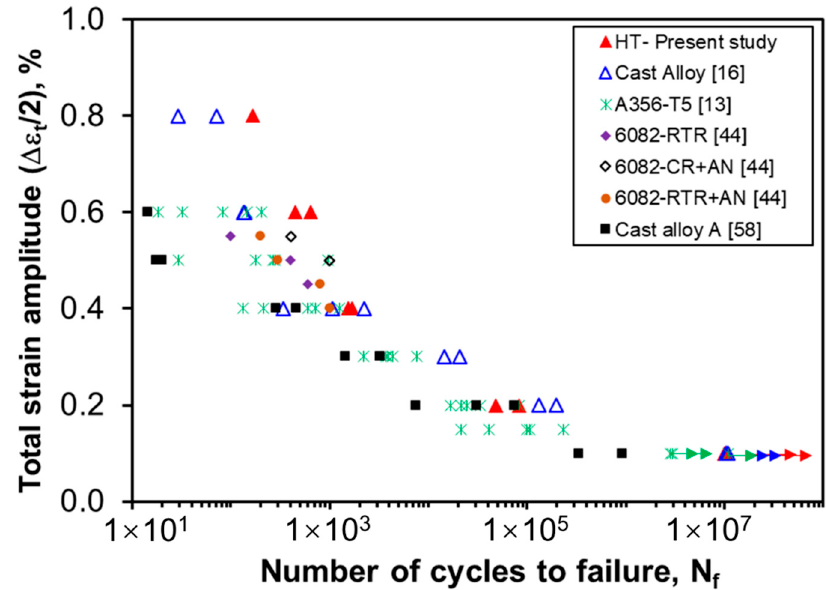
Figure 11. Fatigue life of heat-treated Al alloy in comparison with that of other alloys reported in the literature.